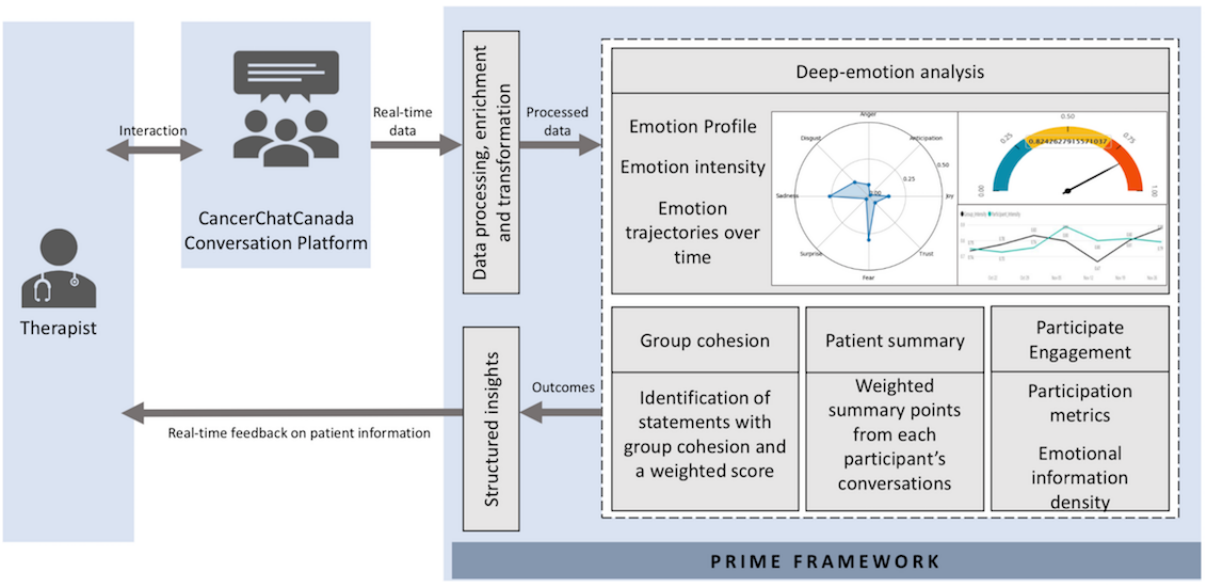
Figure 2. Functionalities of AICF. PRIME: Patient-Reported Information Multidimensional